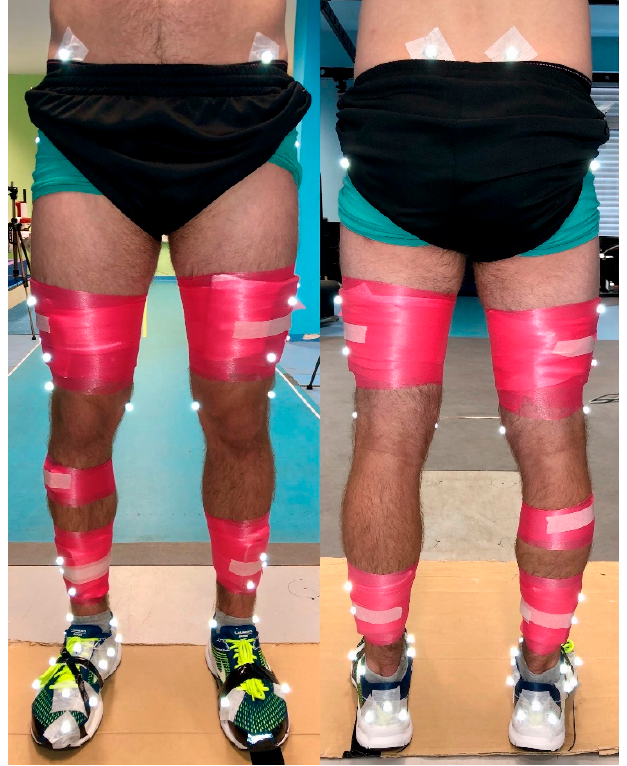
Figure 2. Reflective calibration and tracking markers placement and EMG sensors placement for biomechanical analysis.